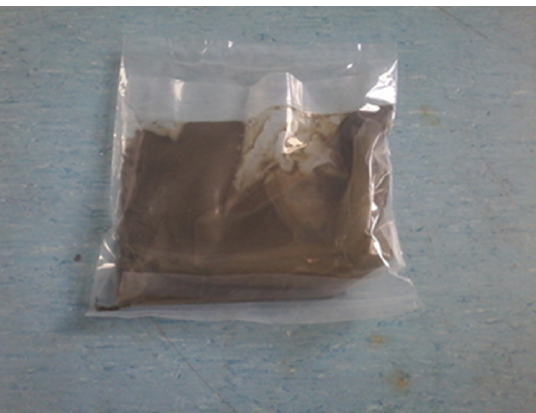
Figure 5. Sample of sewage sludge sealed in a polyethylene bag (120 µm foil thickness) prepared for irradiation by an Elektronika 10/10 electron accelerator.